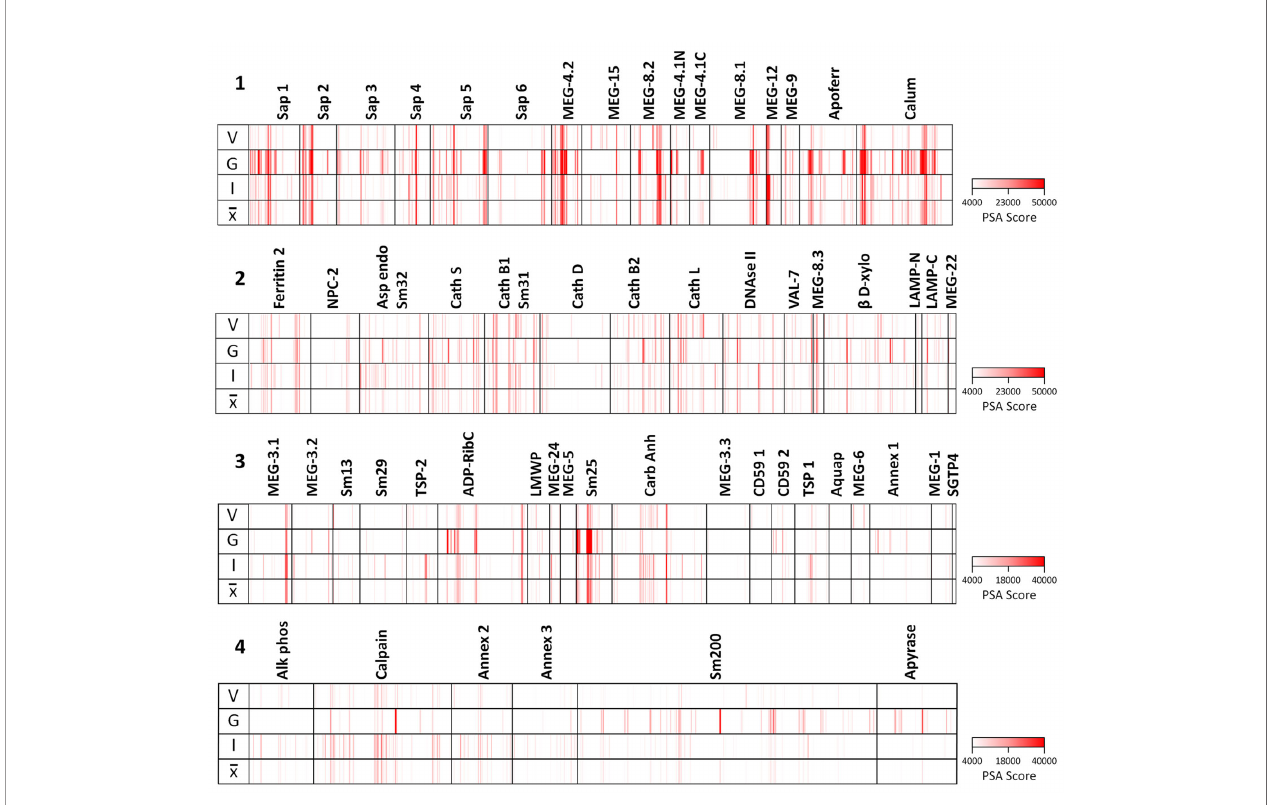
FIGURE 3 | Heatmaps of the mean reactivities of murine serum pools against the peptide arrays: 1) short alimentary tract; 2) longer alimentary tract; 3) short tegument surface; 4) long tegument surface. V, mean of three C57Bl/6 samples from mice vaccinated with three exposures of 500 radiation-attenuated cercariae. G, mean of two IFNgR KO samples, MT2 and MT3 passive transfer experiments. I, mean of three C57Bl/6 samples from mice exposed to 500 normal cercariae for 4 weeks. (cid:1) x, mean of all eight